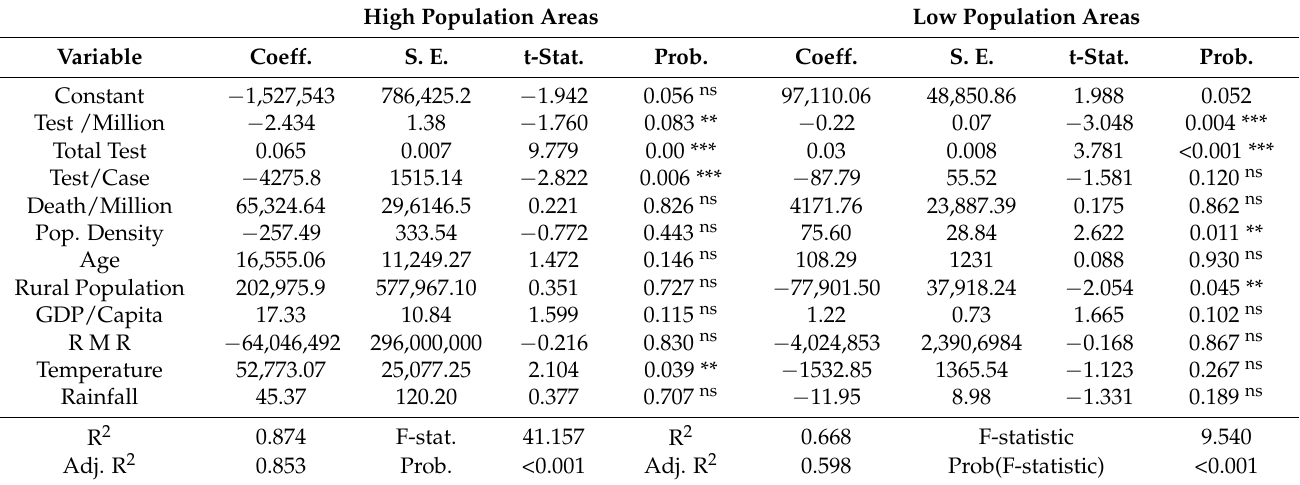
Table 5. Result of OLS regression analysis on factors affecting number of cases of COVID-19. High Population